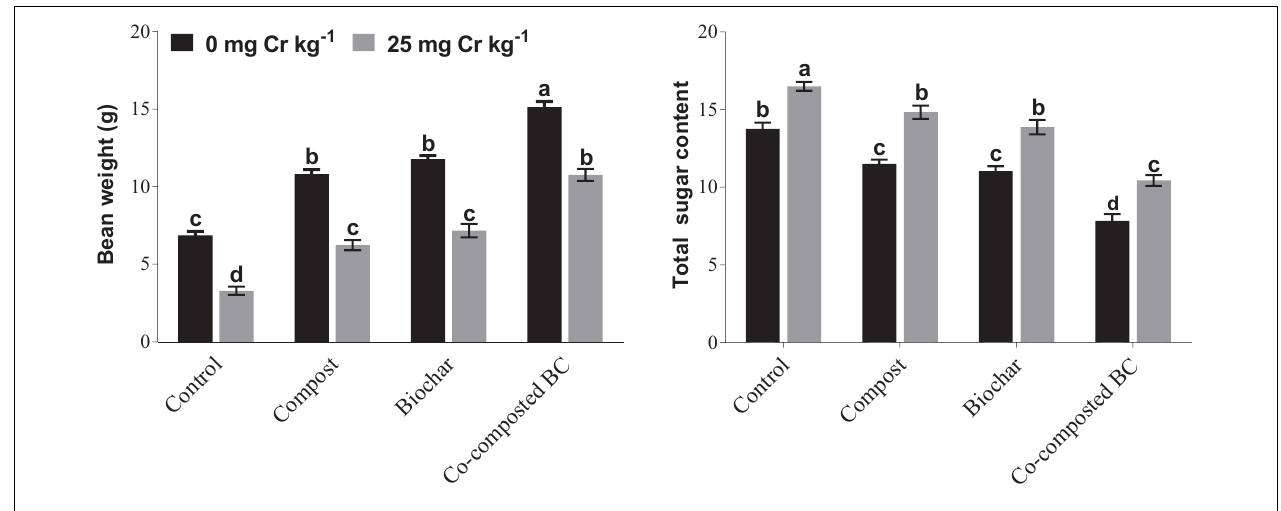
FIGURE 4 | Impact of compost, biochar, and co-composted biochar on bean weight and total sugar contents (TSCs) of Brassica napus . The values are presented as mean ± standard error ( n = 3). The values sharing the same letter(s) in bars are statistically non-significant with each other at p < 0.05.